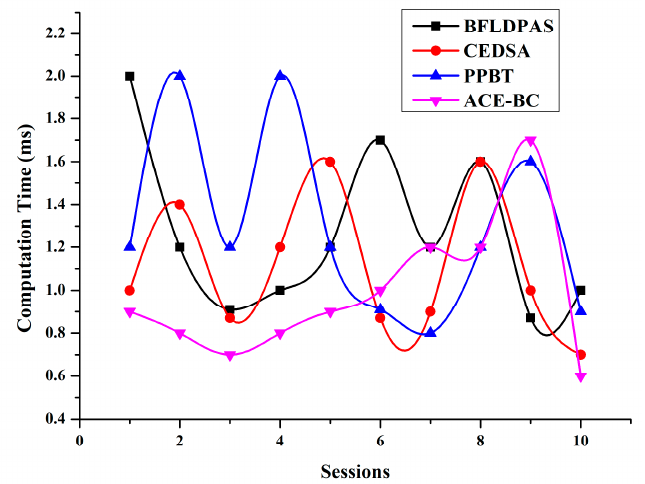
Figure 9. Computation Time.